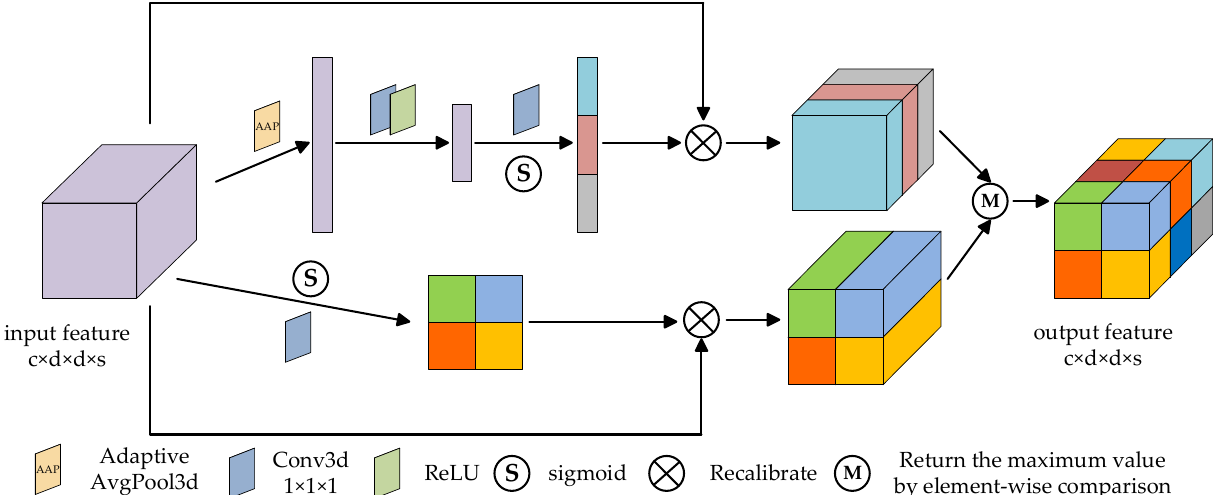
Figure 4. The schematic diagram of the global 3D attention module.